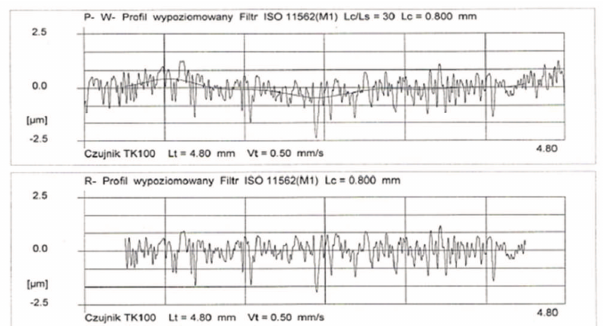
Fig.10. Cylinder no. 2 – wall’s profile